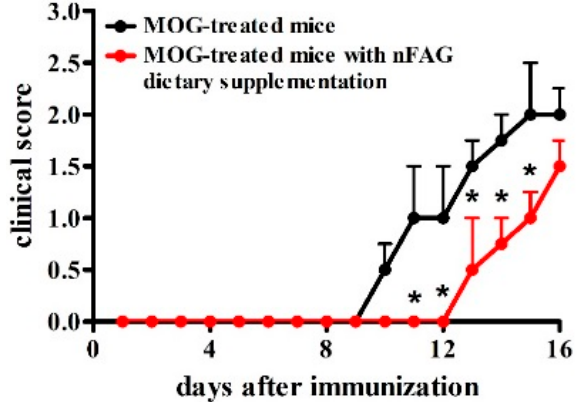
Figure 1. Neuro-FAG (nFAG) dietary supplementation delays the onset of experimental autoimmune encephalomyelitis (EAE). Myelin oligodendrocyte glycoprotein (MOG)-treated mice, without or with nFAG dietary supplementation ( n = 13 for each experimental group), were examined daily until their sacrifice, 16 days after MOG administration, using a clinical EAE scoring system ranging from 0 (no signs) to 5 (complete paralysis or death). * p < 0.05 versus MOG-treated mice (two-way ANOVA followed by Bonferroni’s multiple comparison post-test). Black circles and black line, MOG-treated mice; red circles and red line, MOG-treated mice with nFAG dietary supplementation.